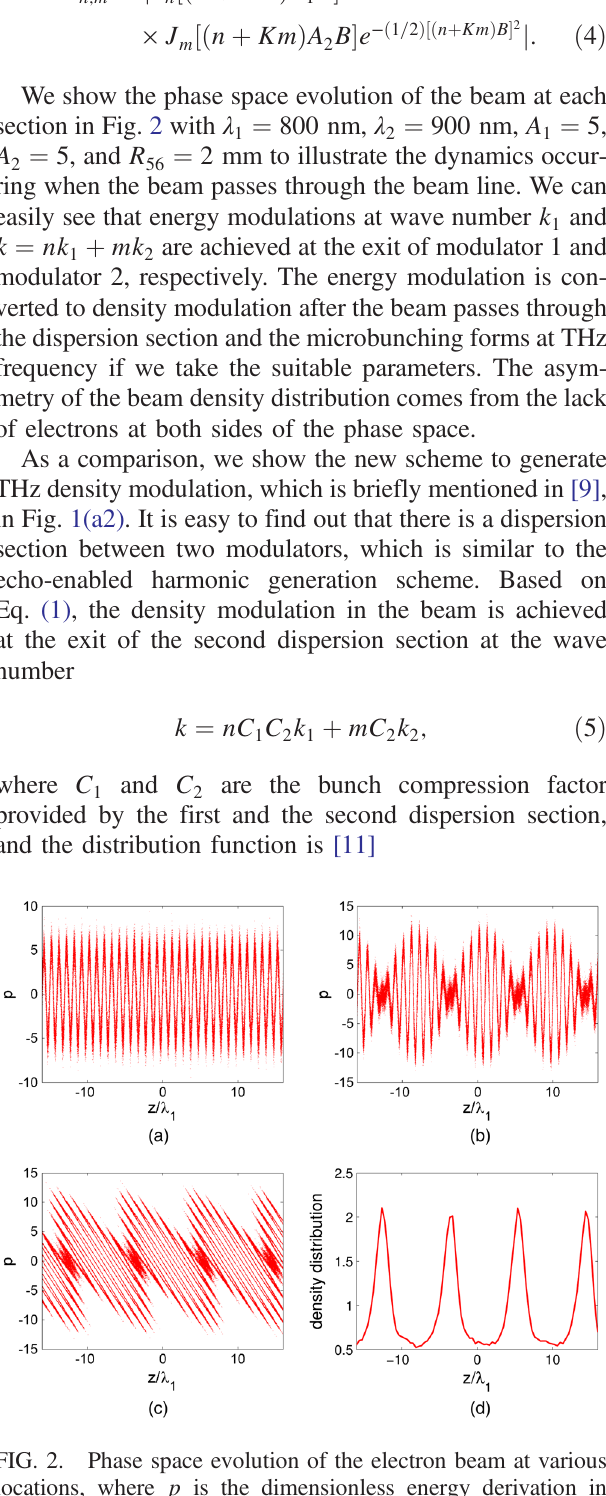
FIG. 1. Layout of two schemes to generate THz density modulation in a relativistic electron beam.